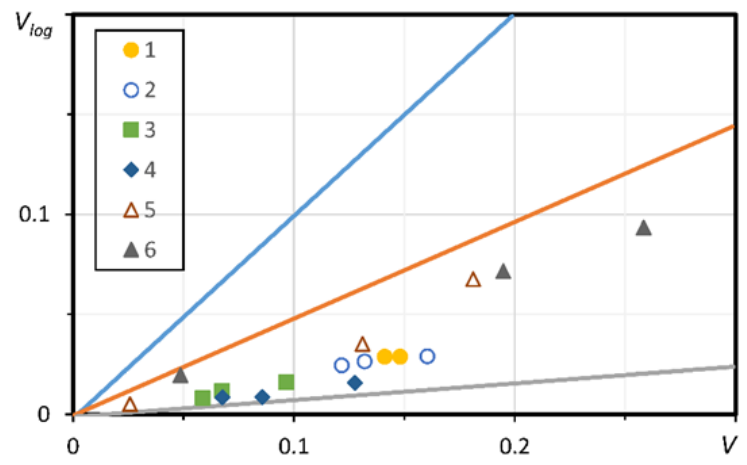
Figure 5. Coefficients of variation of mechanical properties (x-axis — normal and Weibull; y-axis —